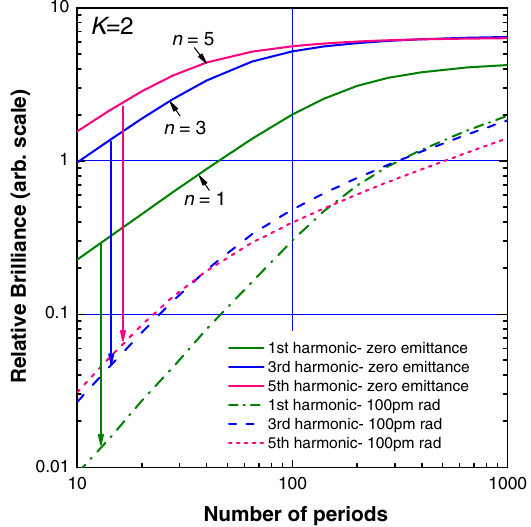
FIG. 11. Dependence of the relative average brilliance on the number of undulator periods for zero emittance or a finite emittance of 100 pm rad and an energy spread of 10 − 3 . The values for finite emittances have been obtained from SPECTRA [86]. The parameters for the calculation were E β ¼ 5 . 3 m, β ¼ 1 . 7 m, a coupling constant of 0.01 and an x y energy spread of 10 − 3